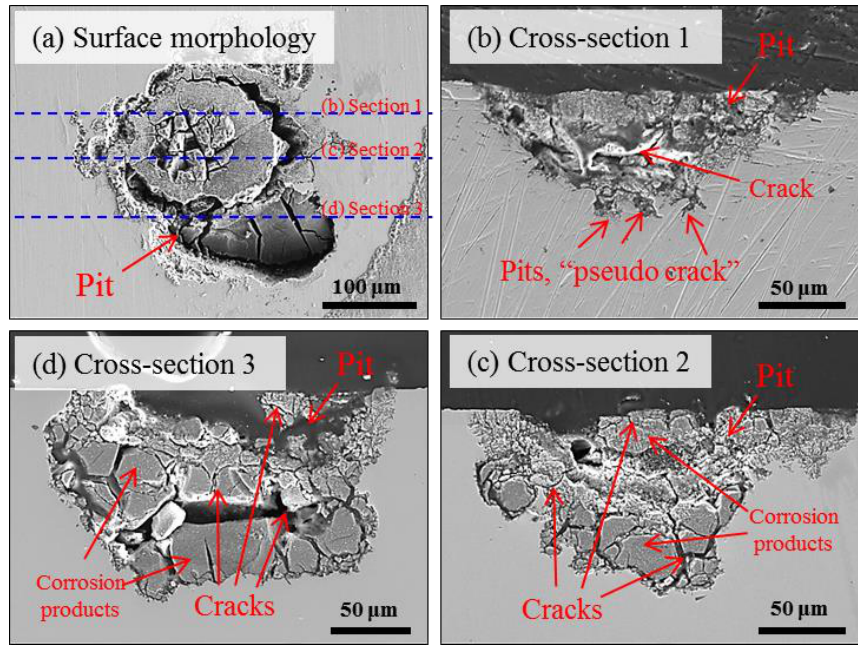
Figure 12. SEM images via serial sectioning of the localized corrosion area in specimen A: ( a ) surface morphology and ( b – d ) Observations of cross-sections 1–3. Online version in color.